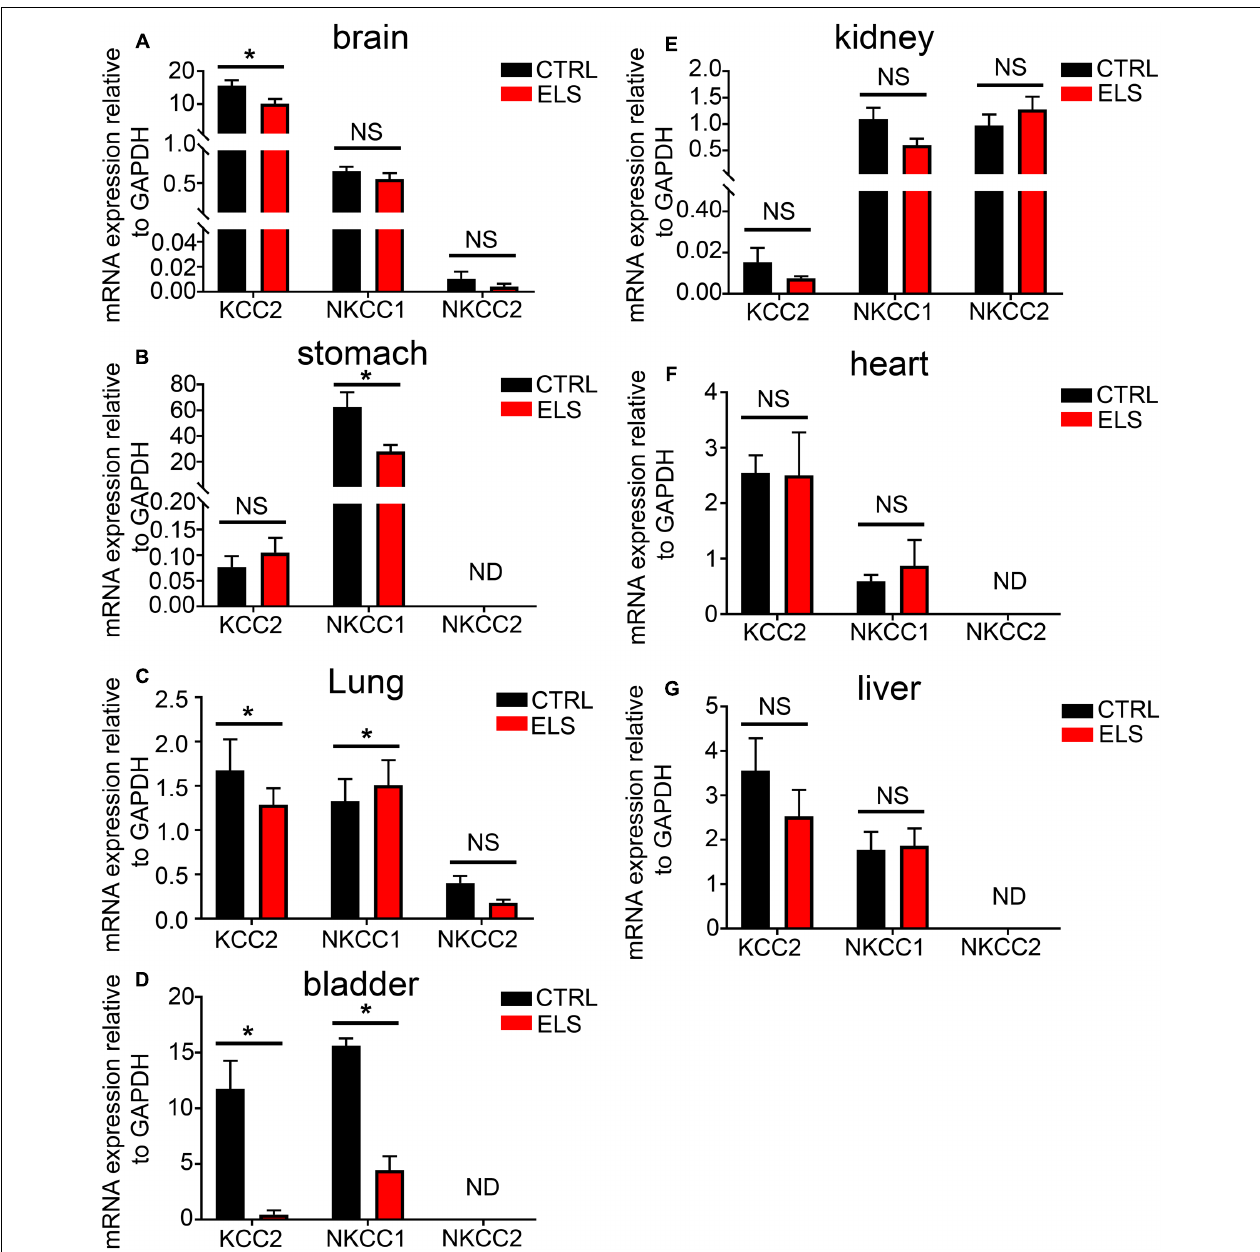
FIGURE 5 | Early life stress (ELS)-induced changes in the level of the potassium-chloride transporter member 5 (KCC2), Na–K–Cl cotransporter 1 (NKCC1), and Na–K–Cl cotransporter 2 (NKCC2) within various peripheral organs. Quantification of the mRNA expression levels of the KCC2, NKCC1, and NKCC2 in (A) brain, (B) stomach, (C) lung, (D) bladder, (E) kidney, (F) heart, and (G) liver tissue from adult mice (PND 60) exposed to ELS. Data represent mean ± SEM; N = 5 animals. NS, not significant. Student’s unpaired t -test. Note that the ELS induced significant changes in the mRNA expression of ion transporters specifically within the brain, stomach, lung, and bladder of the mouse. ∗ P <